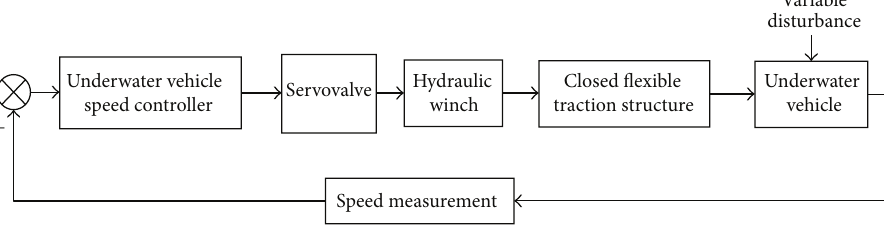
Figure 2: Speed control of the underwater vehicle.